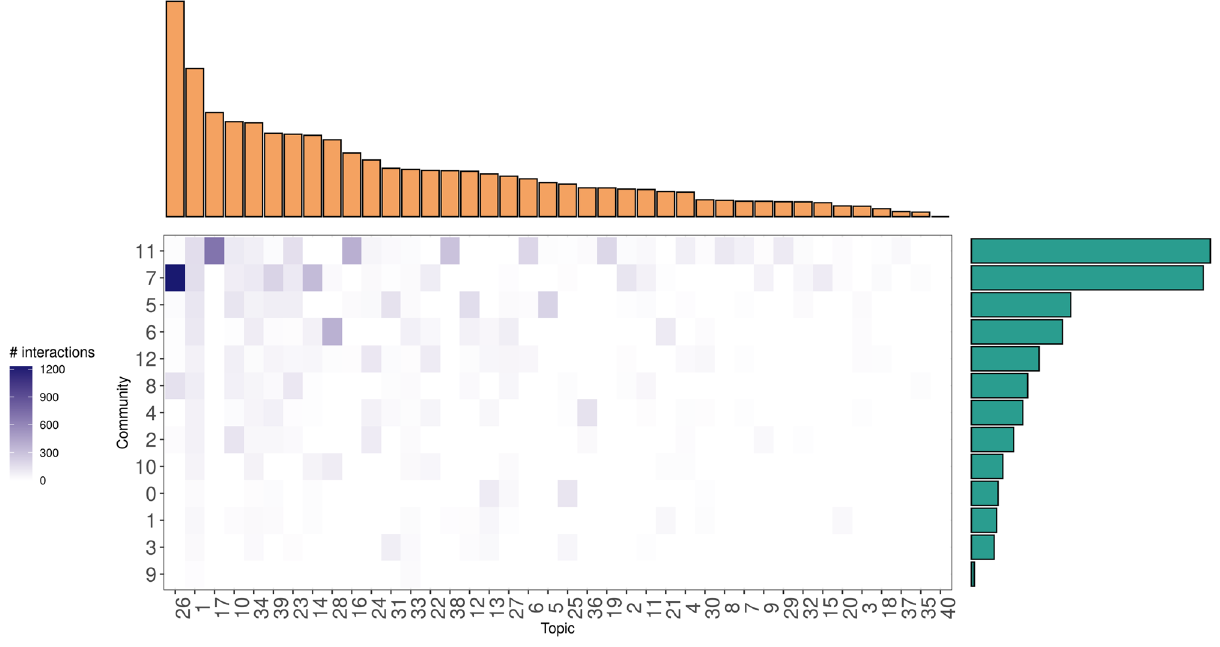
Figure 2. ENRON corpus as a mutualistic network. The interaction matrix is ordered such that most interactions occupy the upper left corner of the matrix. This arrangement is useful to see at a glance the degree of nestedness of the matrix. We note that both axes exhibit a long-tail distribution, which means that generalist communities and topics tend to interact together and that we have a lower proportion of generalists compared to